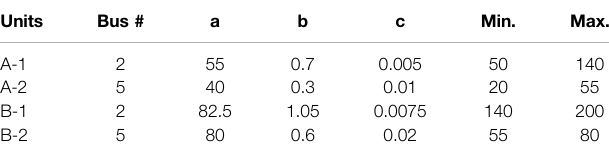
TABLE 5 | Cost coef fi cients for RESs (Biswas et al.,